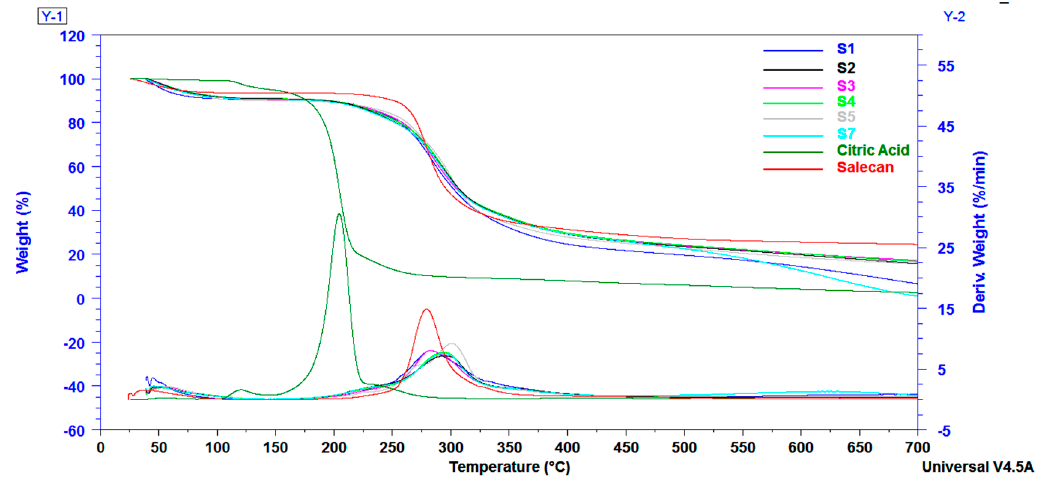
Figure 5. TGA-DTG curves of salecan, citric acid and the crosslinked salecan materials.